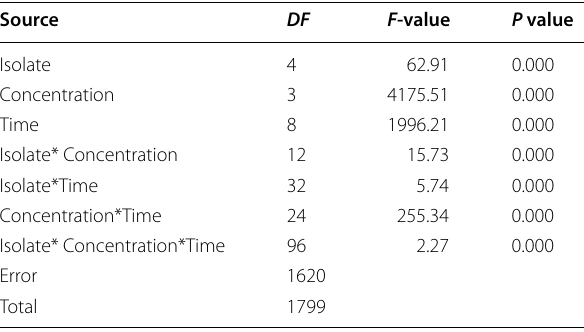
Table 8 ANOVA parameters for main effects and interactions for mortality of Tropinota hirta adults